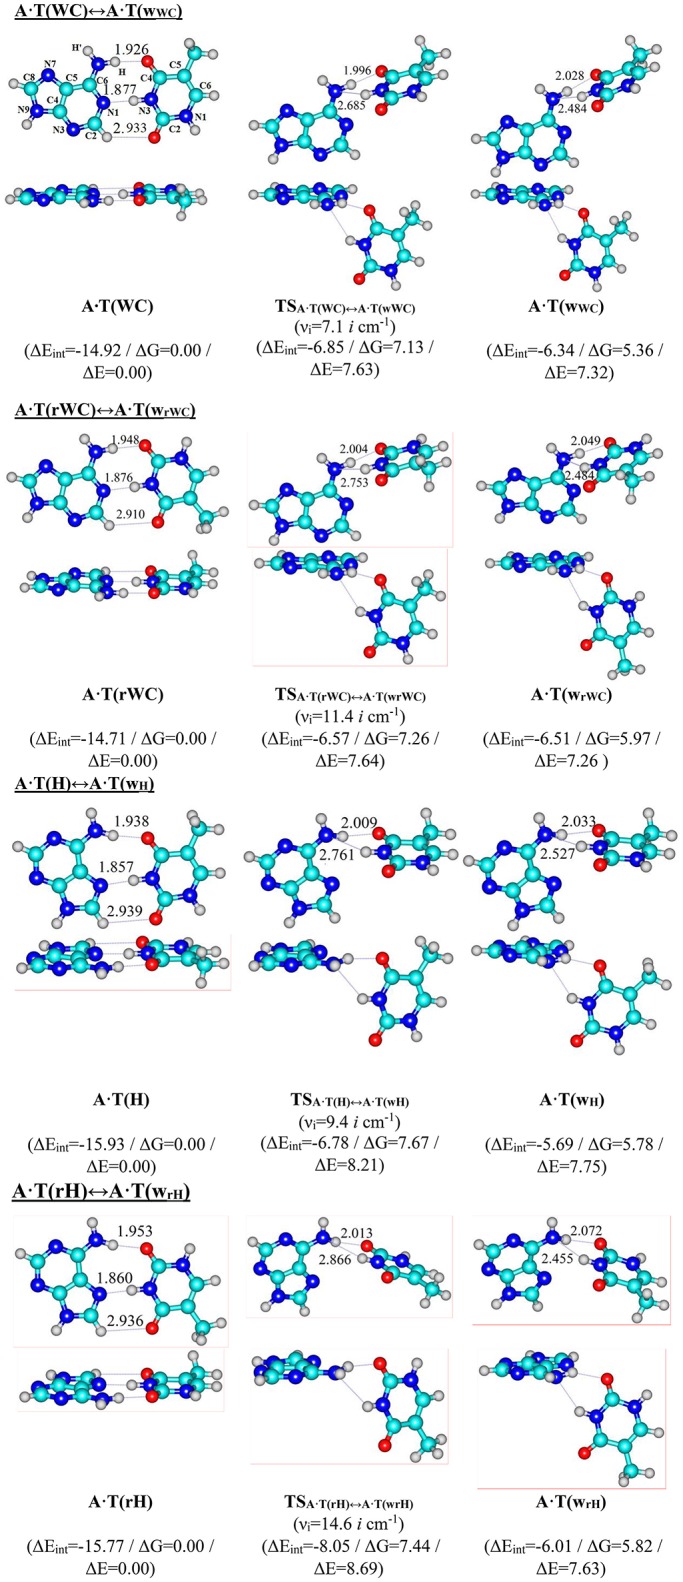
Reaction pathways of the discovered conformational transitions of the four biologically important A·T DNA base pairs. Electronic energies of the interaction ΔEint (MP2/6-311++G(2df,pd)//B3LYP/6-311++G(d,p) level of theory, in kcal·mol−1), relative Gibbs free energies ΔG and electronic energies ΔE (in kcal·mol−1), imaginary frequencies νi at the TSs of the conformational transitions (MP2/aug-cc-pVDZ//B3LYP/6-311++G(d,p) level of theory in the continuum with ε = 4 at T = 298.15 K) are presented below pathways in brackets. Dotted lines indicate AH···B H-bonds – their lengths are presented in angstroms (for more detailed physico-chemical characteristics of the H-bonds see Table 2); carbon atoms are in light-blue, nitrogen – in dark-blue, hydrogen – in gray and oxygen – in red.